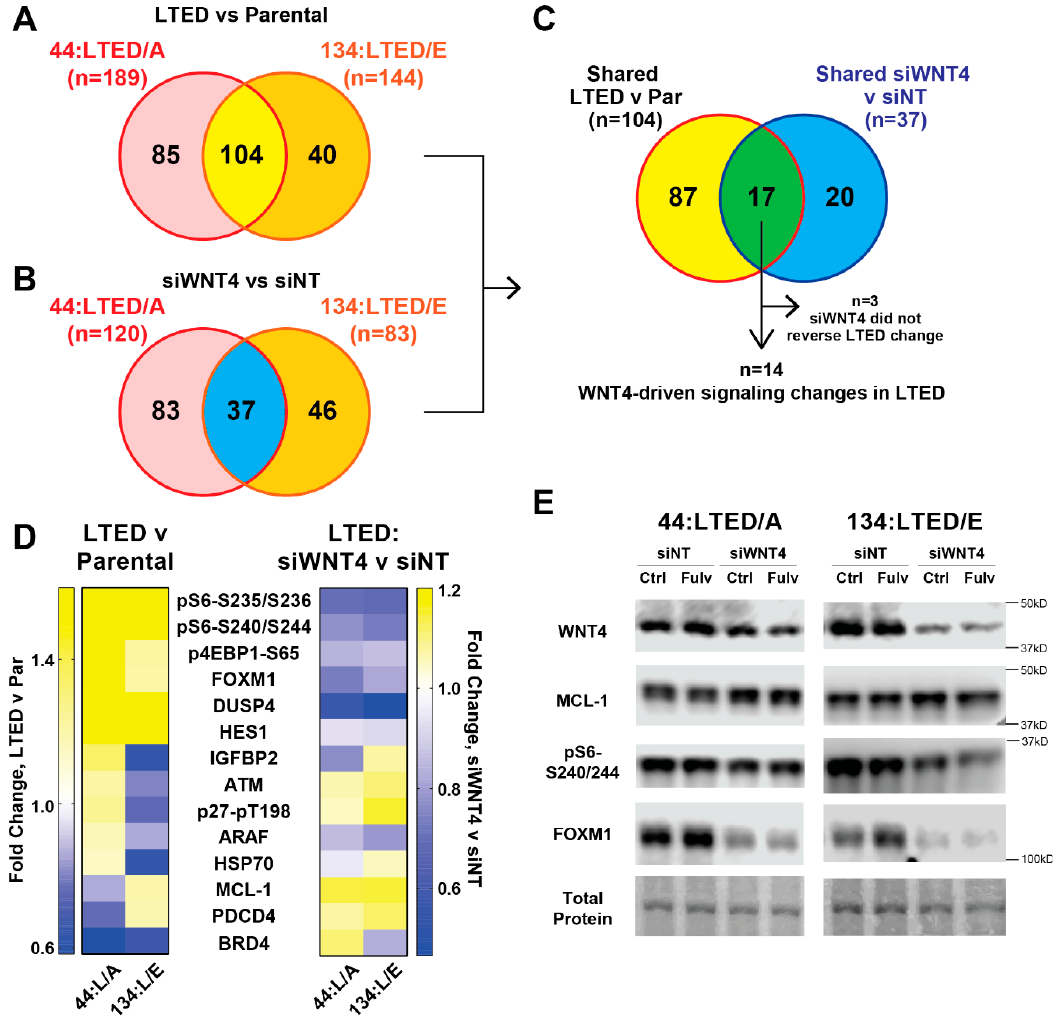
Figure 5. ER:WNT4 signaling targets are similarly active in anti-estrogen resistant ILC models. ( A ) Long-term estrogen deprived (LTED) cells were compared to their hormone-deprived (vehicle treated) parental cell line; differences at q < 0.05 shown. ( B ) LTED cells were reverse transfected with the indicated siRNA for 48 h prior to harvest for RPPA analyses. RPPA protein signaling changes for siWNT4 + E2 vs. siNT + E2 shown ( p < 0.05). ( C ) Overlap between signaling activation in LTED (from ( A )) vs. WNT4-driven signaling (from ( B )) to identify specific WNT4-driven signaling that is activated during anti-estrogen resistance. For n = 3, siWNT4 did not reverse the changes seen in LTED v parental in at least one of the two model systems. ( D ) Heatmap of n = 14 genes from ( C ) for LTED v parental fold change (left) and siWNT4 v siNT fold change (right). Boxes show mean of biological triplicate samples. ( E ) LTED cells (in hormone-deprivation) were reverse transfected with the indicated siRNA. Then, 24 h later, cells were treated with 1 μ M fulvestrant or vehicle, and lysates were harvested after an additional 24 h. Total protein detected with Ponceau staining (also see quantification in Figure S6B).